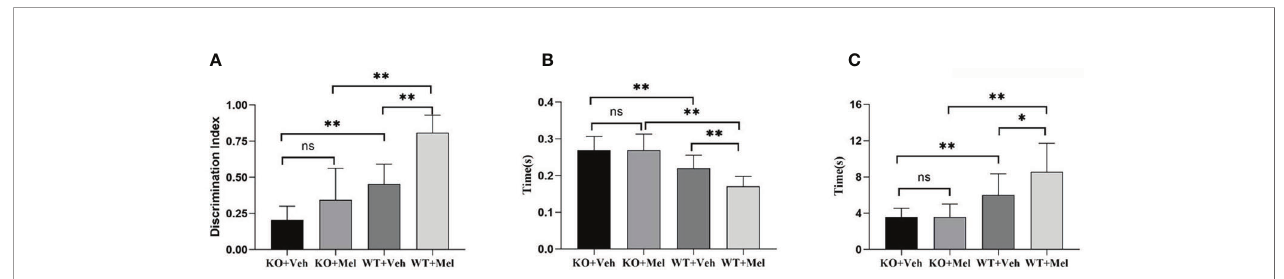
FIGURE 6 | Behavioral test in wild-type mice with HI injury treated with vehicle or melatonin as well as knockout mice with HI injury receiving vehicle and melatonin treatments as indicated. (A) Novel object recognition test; (B) Surface righting re fl ex test; (C) Forelimb suspension re fl ex test. [Two-way ANOVA, Bonferroni post hoc test (details are shown in